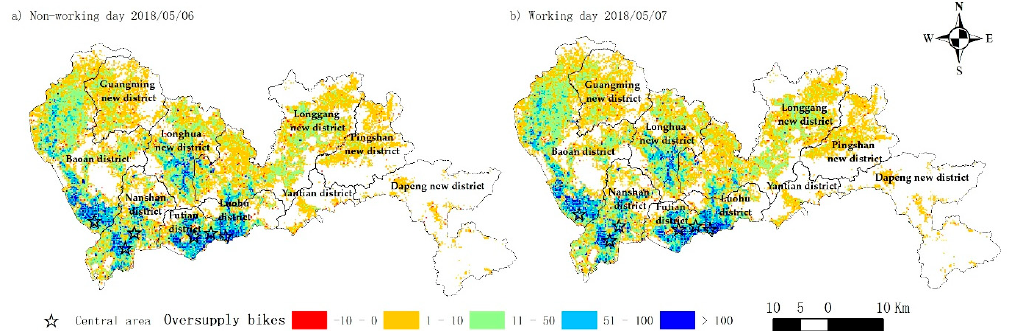
Figure 4. Difference between the actual number of available bikes and the number of optimized bikes in two days.